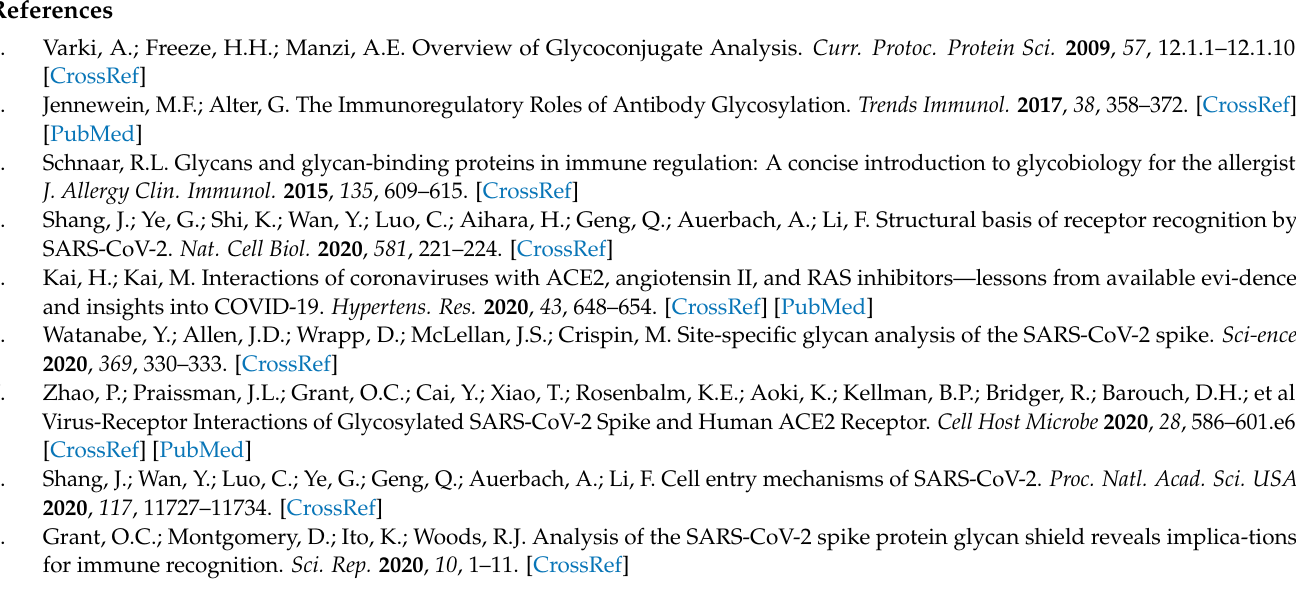
Figure S2: Blood group system biosynthesis pathway overlayed with the DEGs identified from the SARS-CoV-2 nasopharyngeal swab